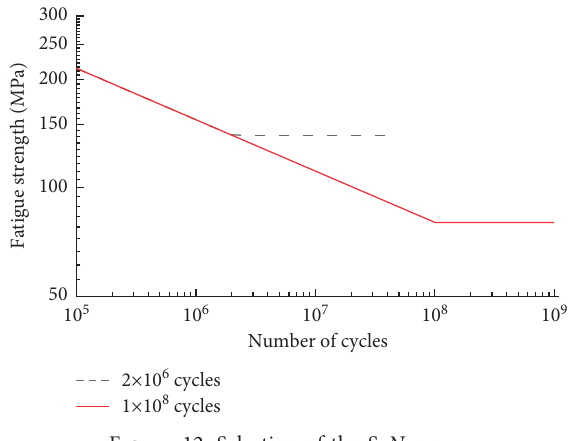
Figure 12: Selection of the S–N